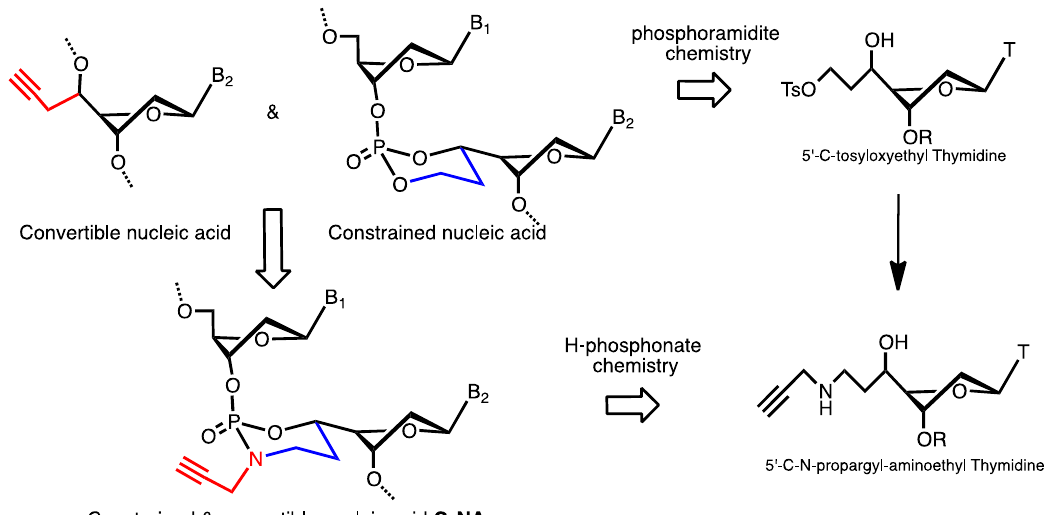
Figure 13. Lowest energy conformations from the in silico protocols. Left: ( R C5’ , R P )- α , β -C 2 NA. Right: ( S C5’ , S P )- α , β -D-C 2